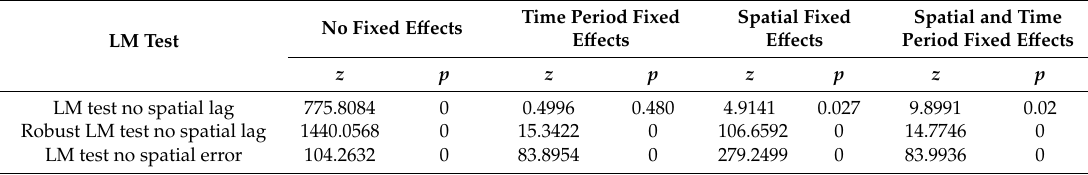
Table 4. LM test of spatial panel model.